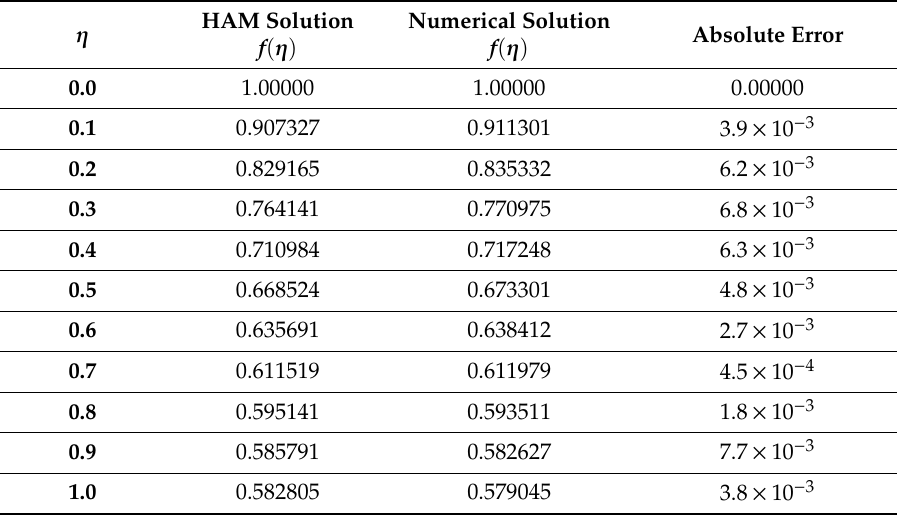
Table 2. Comparison of HAM and numerical solution for f ( η )